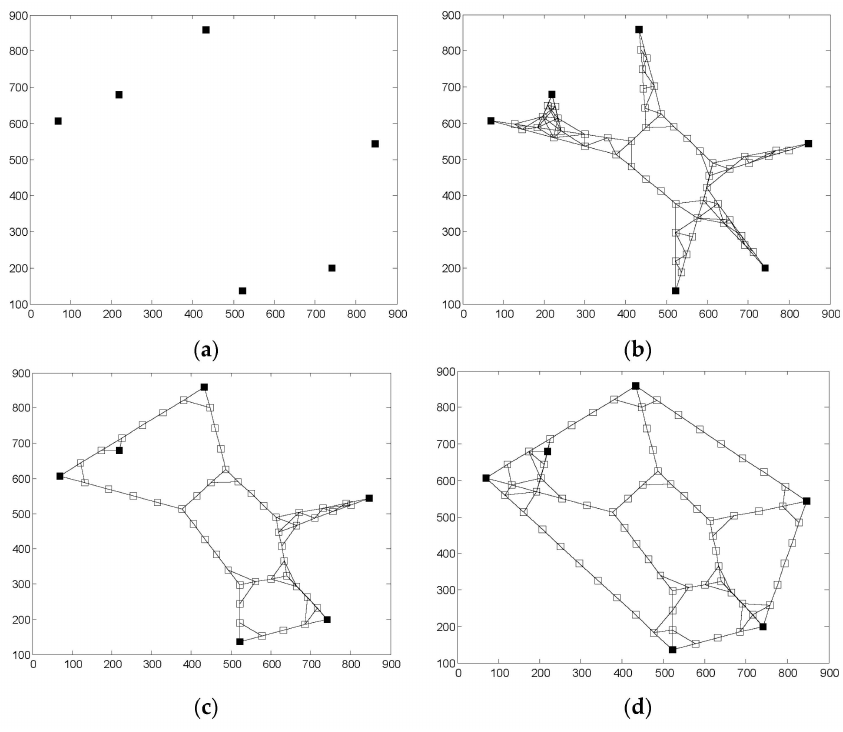
Figure 5. ( a ) The distribution of segments before the restoration; ( b ) 2C-SpiderWeb; ( c ) F2CRA; and ( d )